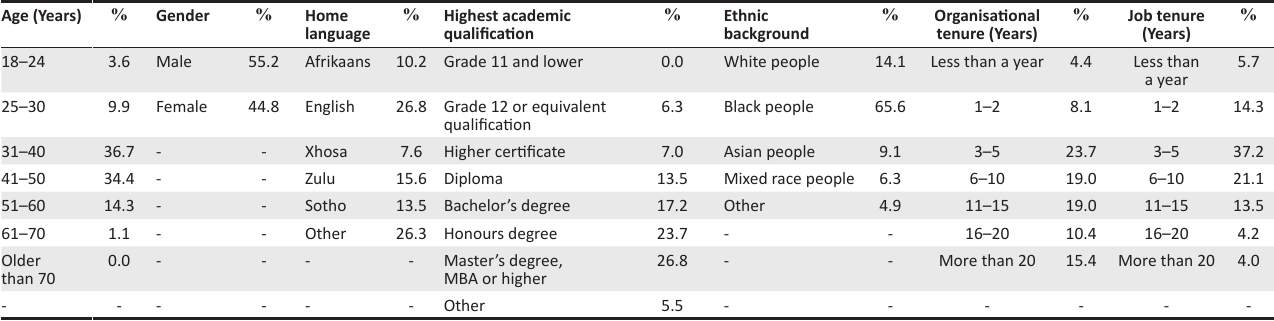
TABLE 2: Demographic profile of respondents. Age